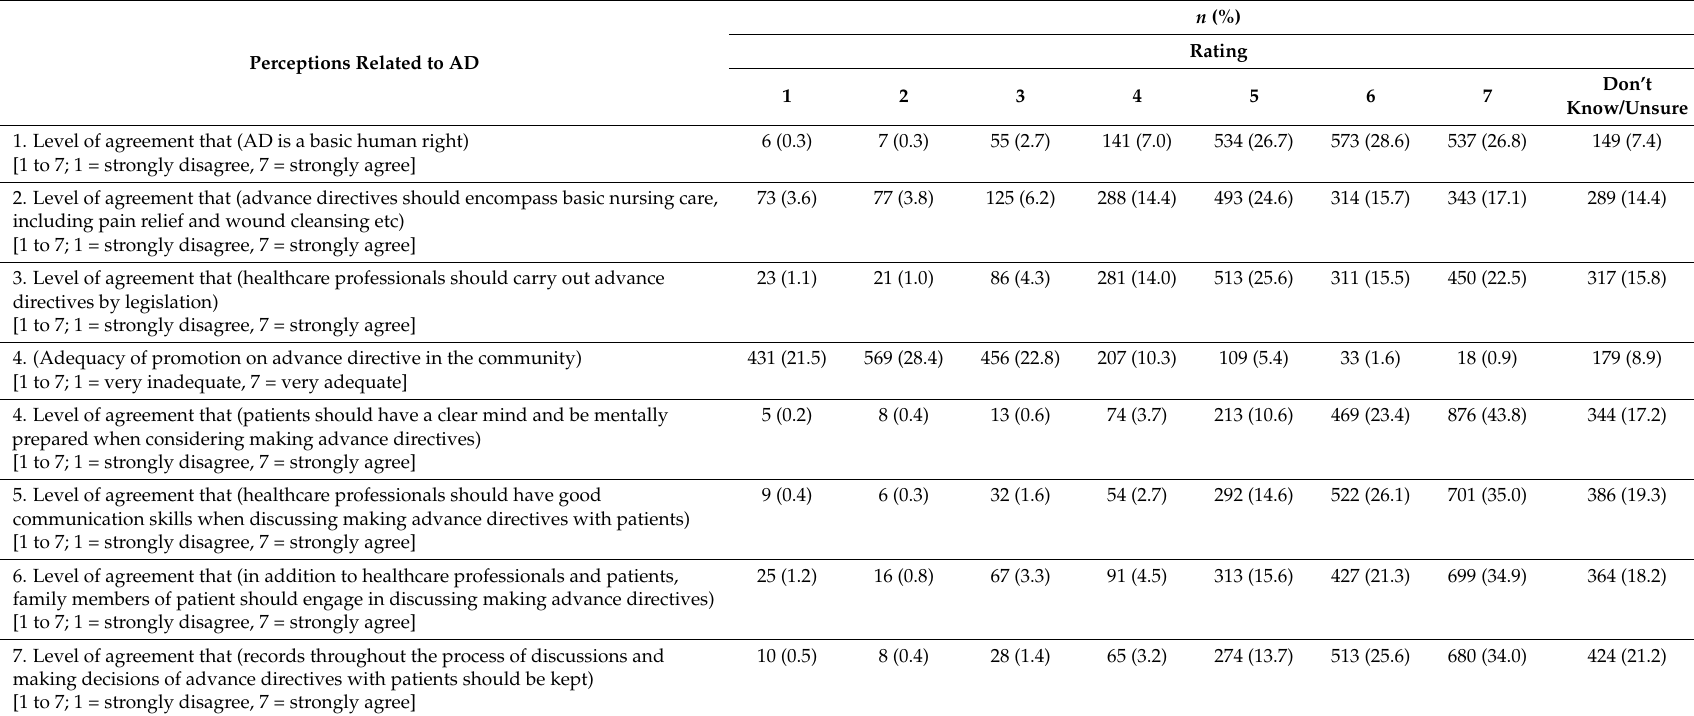
Table 3. Perceptions related to advance directives ( n =